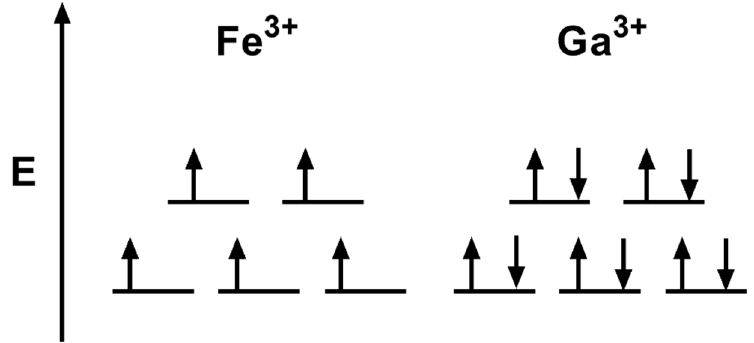
Figure 8. Valence electron configuration of Fe 3+ and Ga 3+ . Energy level diagram of the d-orbital shell of Fe 3+ and Ga 3+ when bound in an octahedral coordination environment (6 ligands). The d-orbital of Fe 3+ is partially filled with 5 unpaired electrons (S = 5/2) while Ga 3+ has a d-orbital with 10 paired electrons (S = 10). The completed d-orbital of Ga 3+ prevents redox cycling (154).